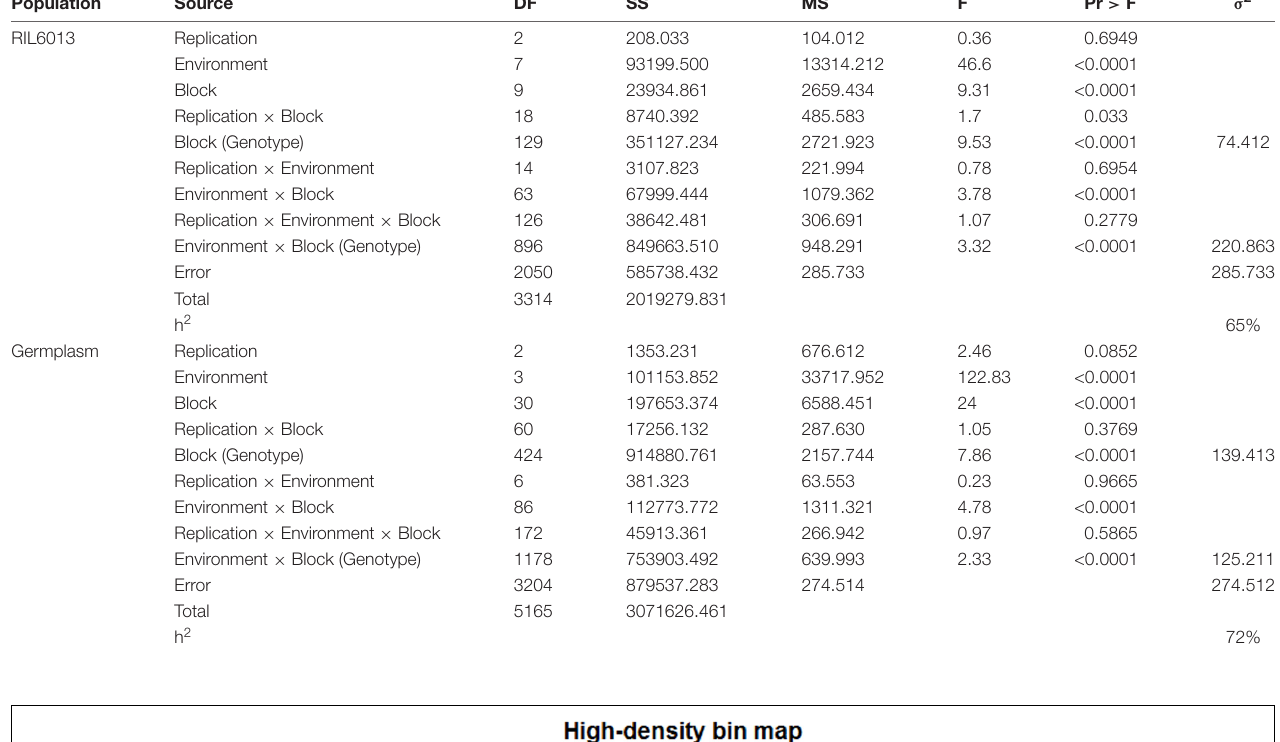
TABLE 2 | Joint ANOVA of PH of RIL6013 population and 455 germplasm resources in multiple environment and heritablity. Population